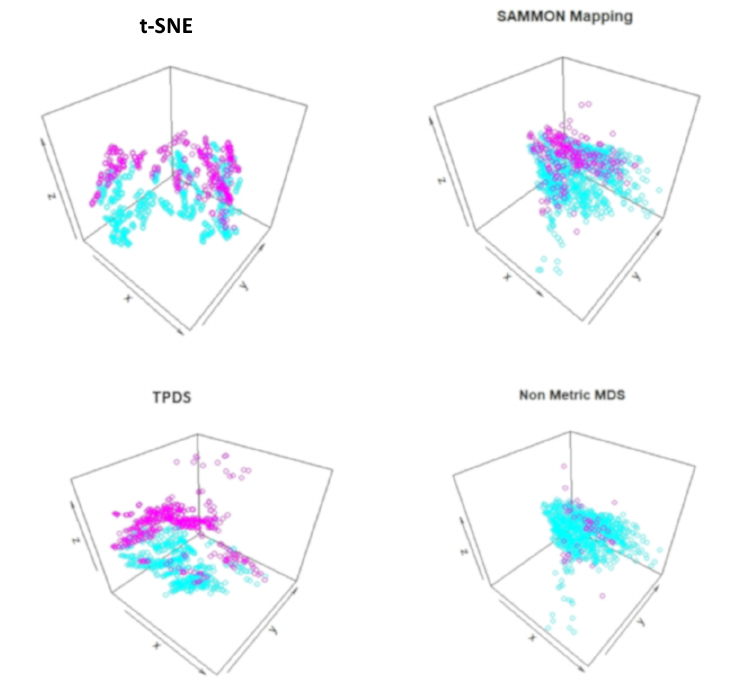
Figure 3. Visualization of mouse protein data set after reduction to three dimensions. The trisomic and normal mice data-points are shown with two di ff erent colors. TPDS is able to show clear separation between trisomic and normal mice